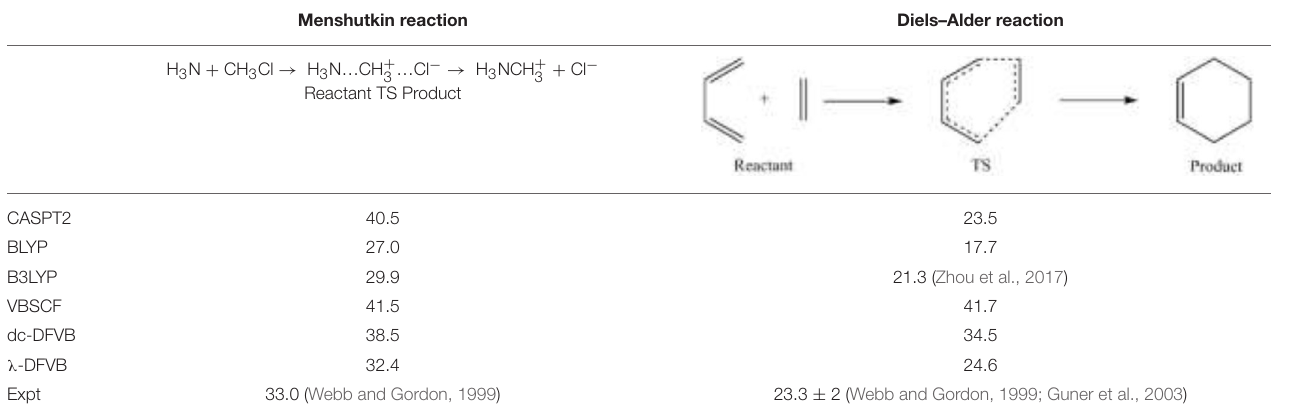
TABLE 3 | The barriers of the D-A and Menshutkin chemical reactions (in kcal/mol). Menshutkin